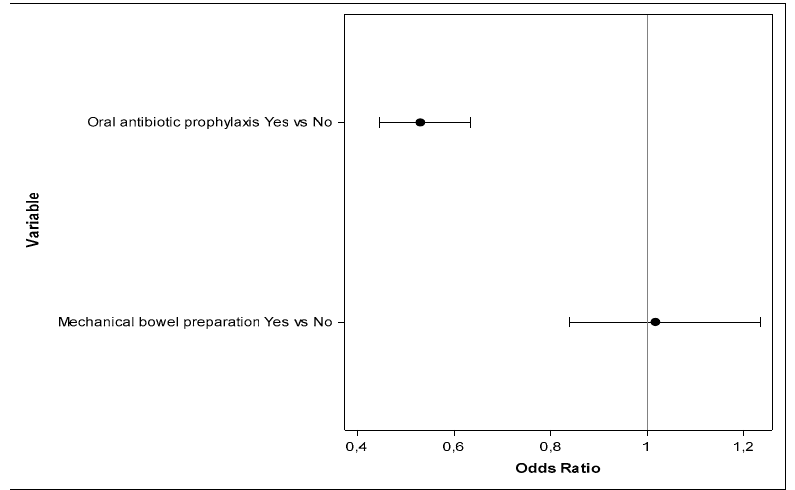
Figure 1. OR with 95% confidence interval for variables OAP and MBP from multivariate logistic model, with response variable SSI and antibiotic prophylaxis, laparoscopy, OAP, MBP and wound retractor as independent variables.